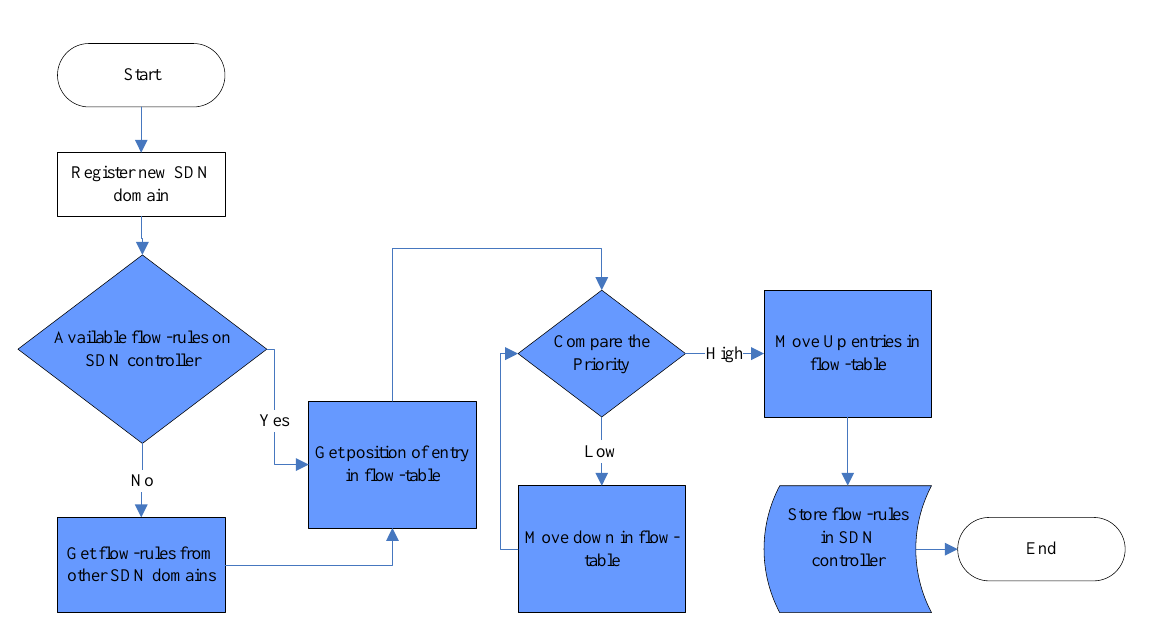
Figure 6. IIF-SDN proactive approach on the SDN controller layer.